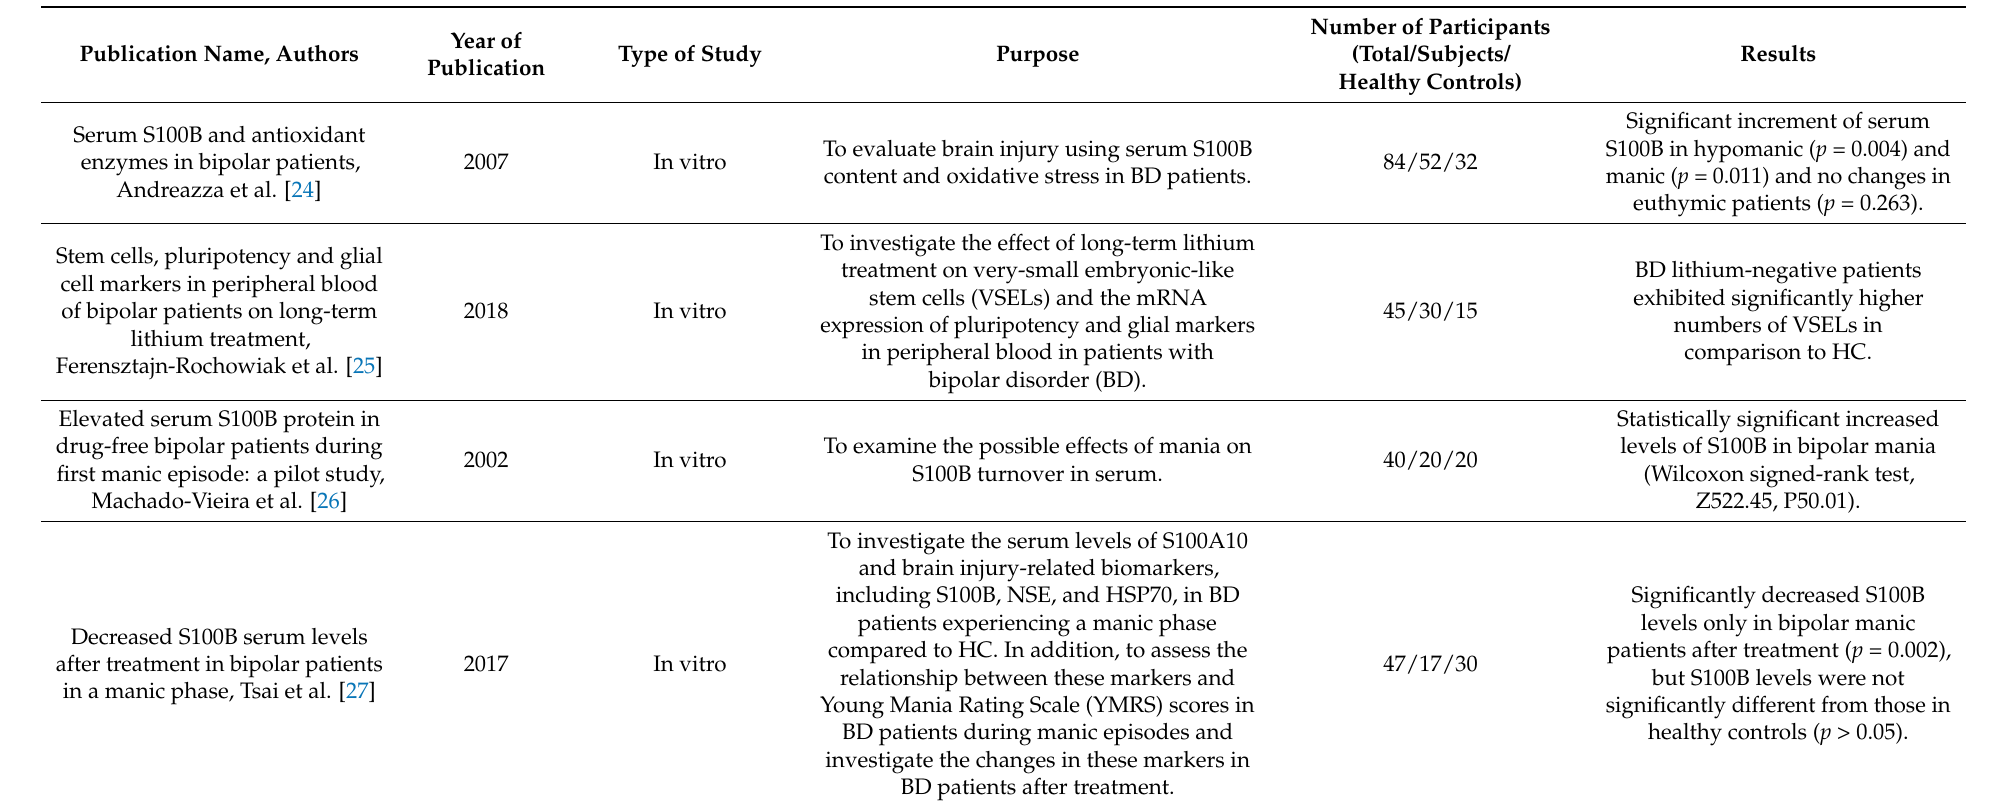
Table 1. Summary of in vitro publications included in the scoping review. Includes publication name, authors, year of publication, type of study, purpose,